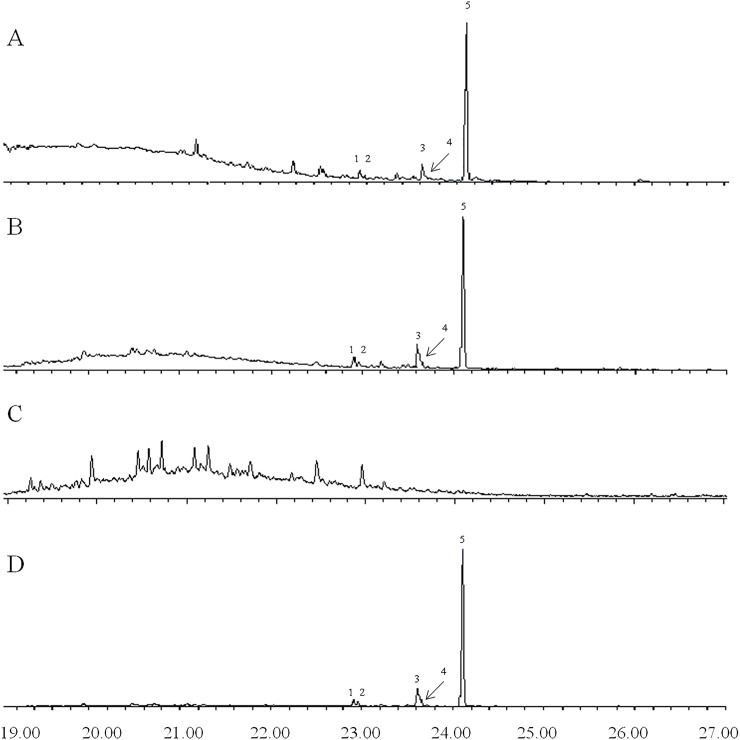
Representative gas chromatograms of VOCs from B. oleracea var. botrytis.(A), B. napus (B), B. carinata (C), and B. oleracea var. botrytis non-polar fraction (D). The peak numbers indicate the diterpene hydrocarbons detected in the analysis.